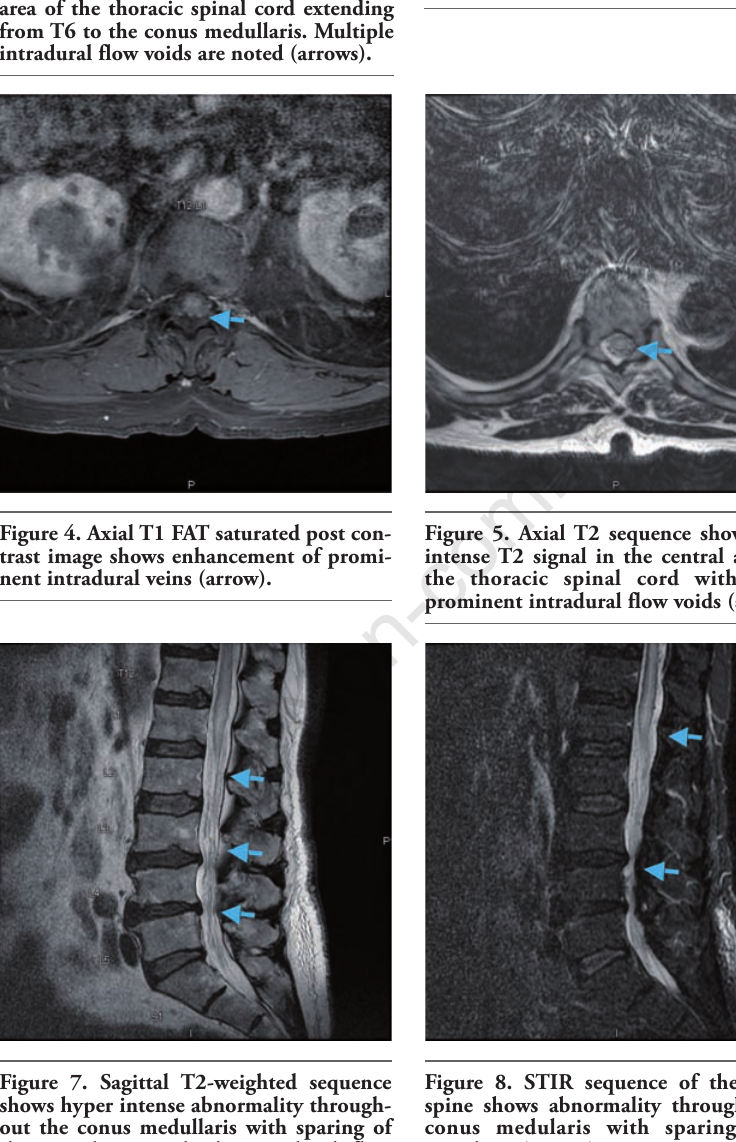
Figure 2. Post-contrast image of the tho- racic spine demonstrates multiple intradural flow voids